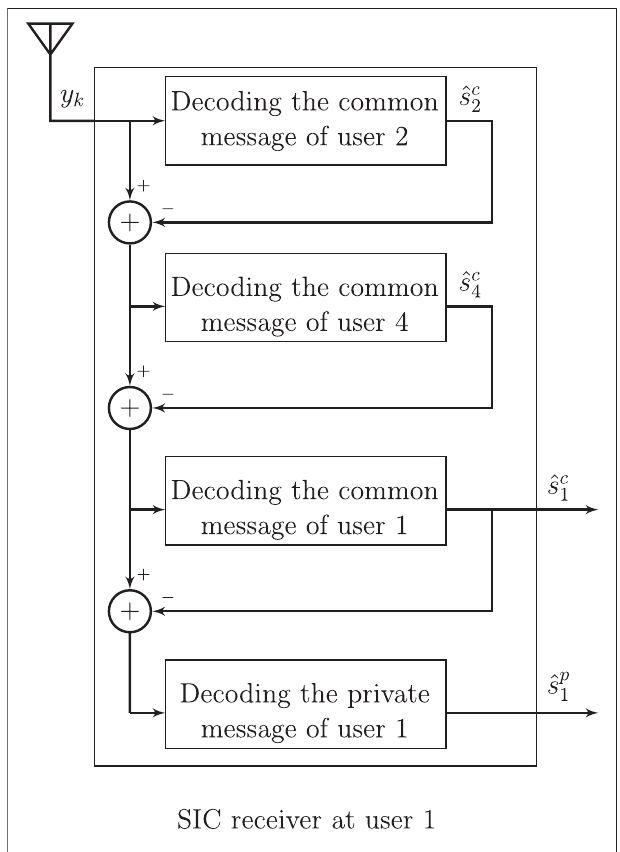
FIGURE 2 | A block diagram for an SIC at user 1. In this example, the common messages decoded at user 1 are Φ 1 (cid:2) {1, 2, 4}. The decoding order at user 1 is then given as π 1 : Φ 1 → {3, 1,